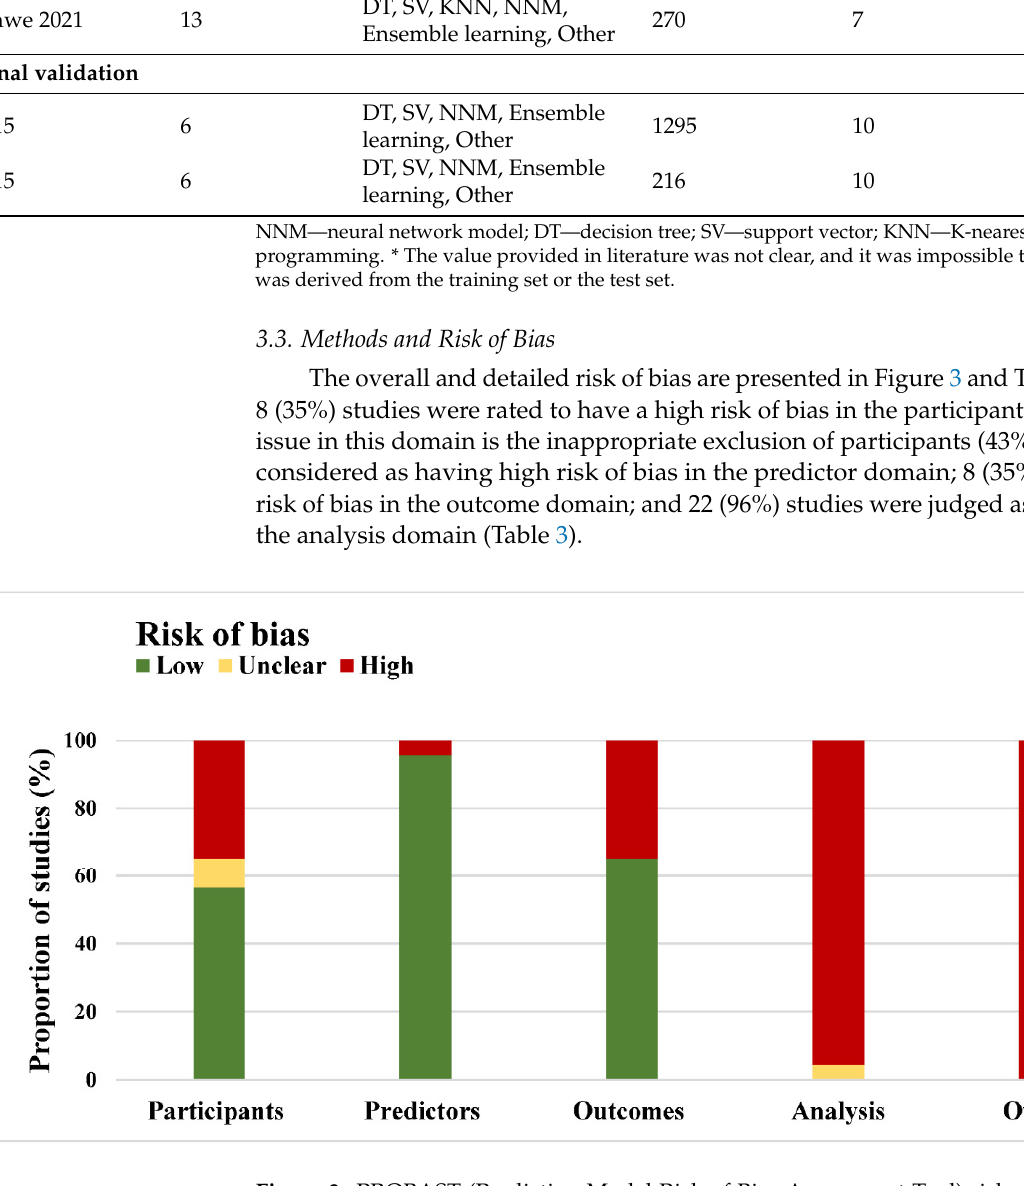
Figure 3. PROBAST (Prediction Model Risk of Bias Assessment Tool) risk of bias assessment for 23 studies.